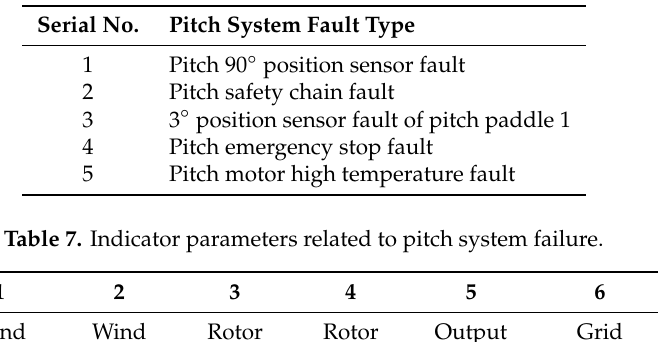
Table 6. Main faults of the pitch system.